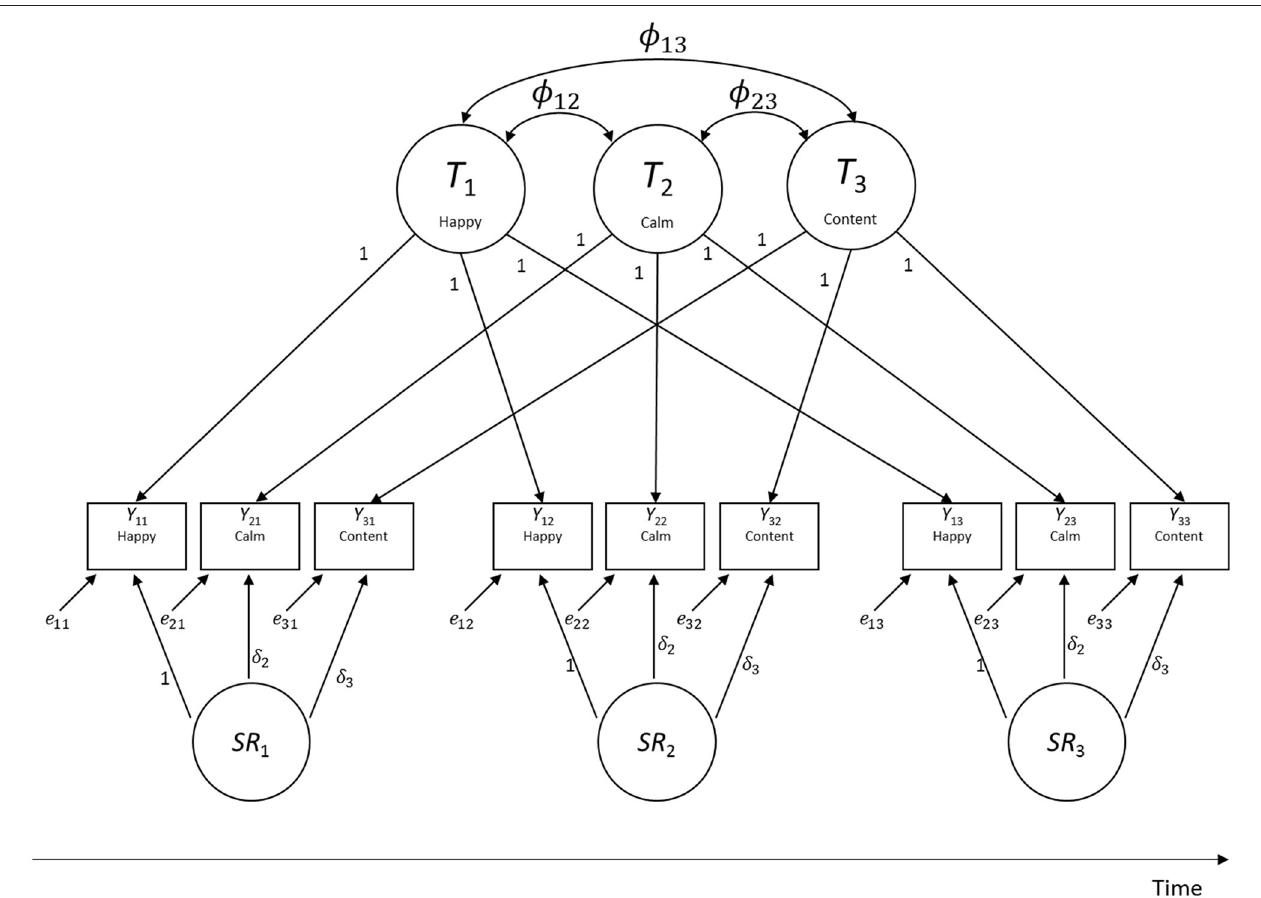
FIGURE 2 | Path diagram of a multitrait-multistate (MTMS) model of LST theory for three indicators measured on three time points. The parameters φ ij indicate covariances between indicator-specific trait factors.